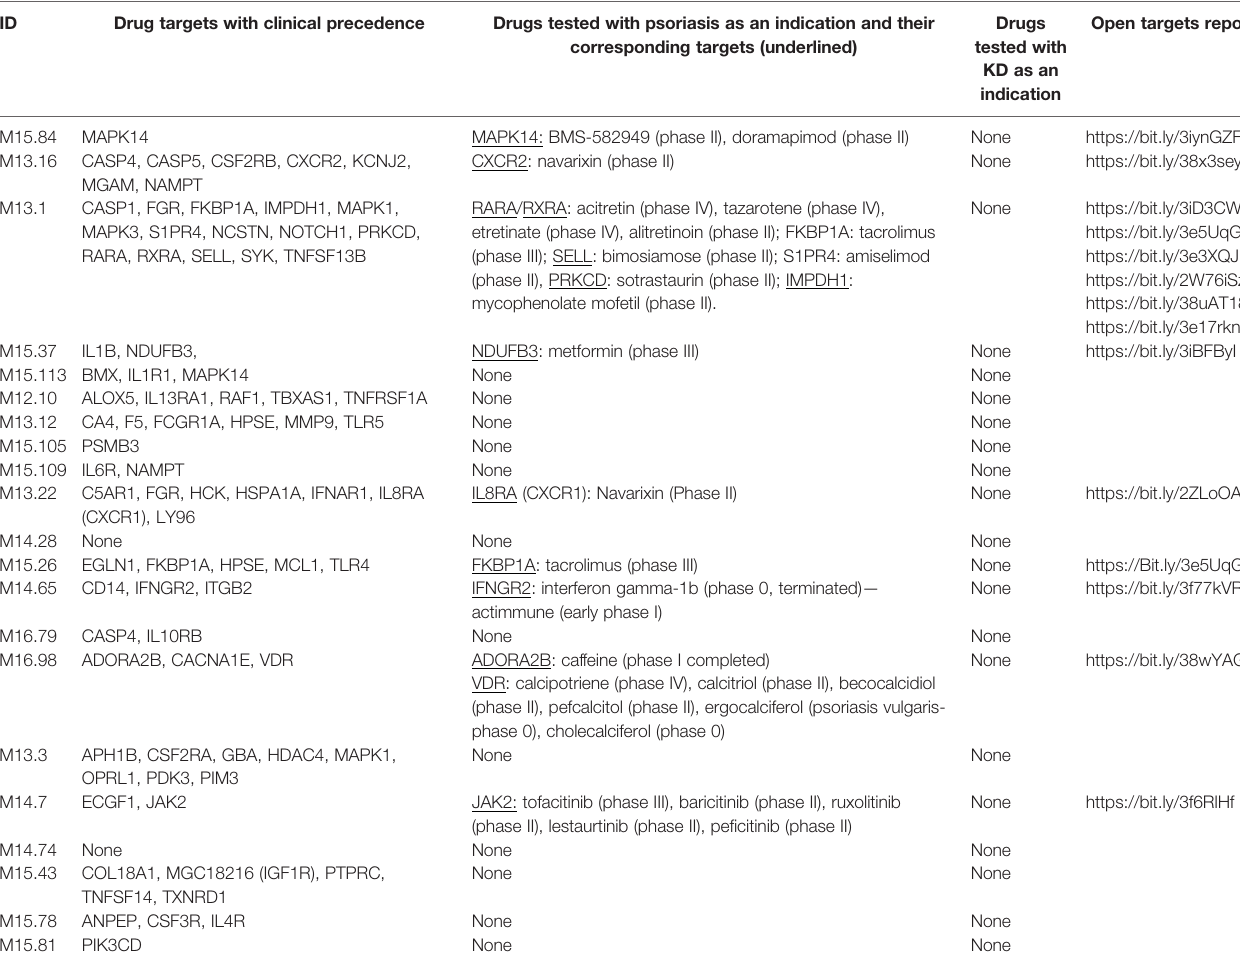
TABLE 1 | Transcripts comprised in aggregate A35 for which the gene products are targetable by existing drugs, and the drugs tested in psoriasis or Kawasaki disease (see Methods ). ID Drug targets with clinical precedence Drugs tested with psoriasis as an indication and their